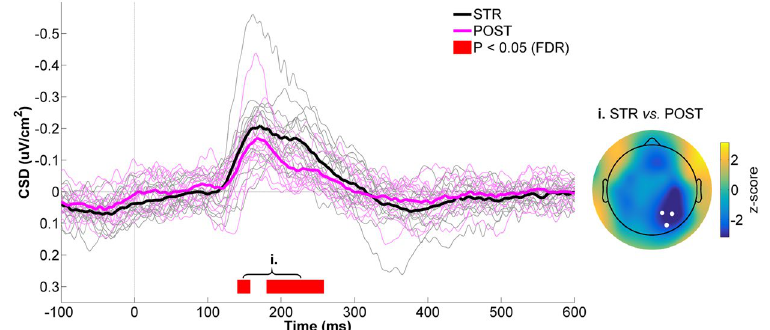
Figure 3. CSD activity recorded at the right parietal ROI for STR vs . POST. The black and magenta waveforms respectively represent CSD activity for STR and POST. The thin waveforms represent individual participant data, whereas the thick waveforms represent the mean CSD activity across participants. The red line highlights the time bins showing statistically significant differences between STR and POST ( p ≤ 0.05, FDR-corrected). Time “0 ms” corresponds to movement onset. The scalp map represents the statistical z-scores across electrodes for CSD activity between STR and POST during the significant time window (i. 140–260 ms). The electrodes that make up the right parietal ROI (P2, P4 and PO4) are highlighted in the scalp